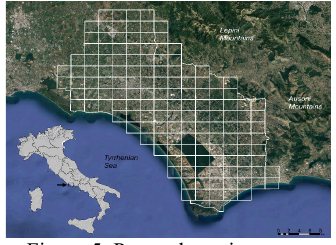
Figure 5. Pre-reclamation